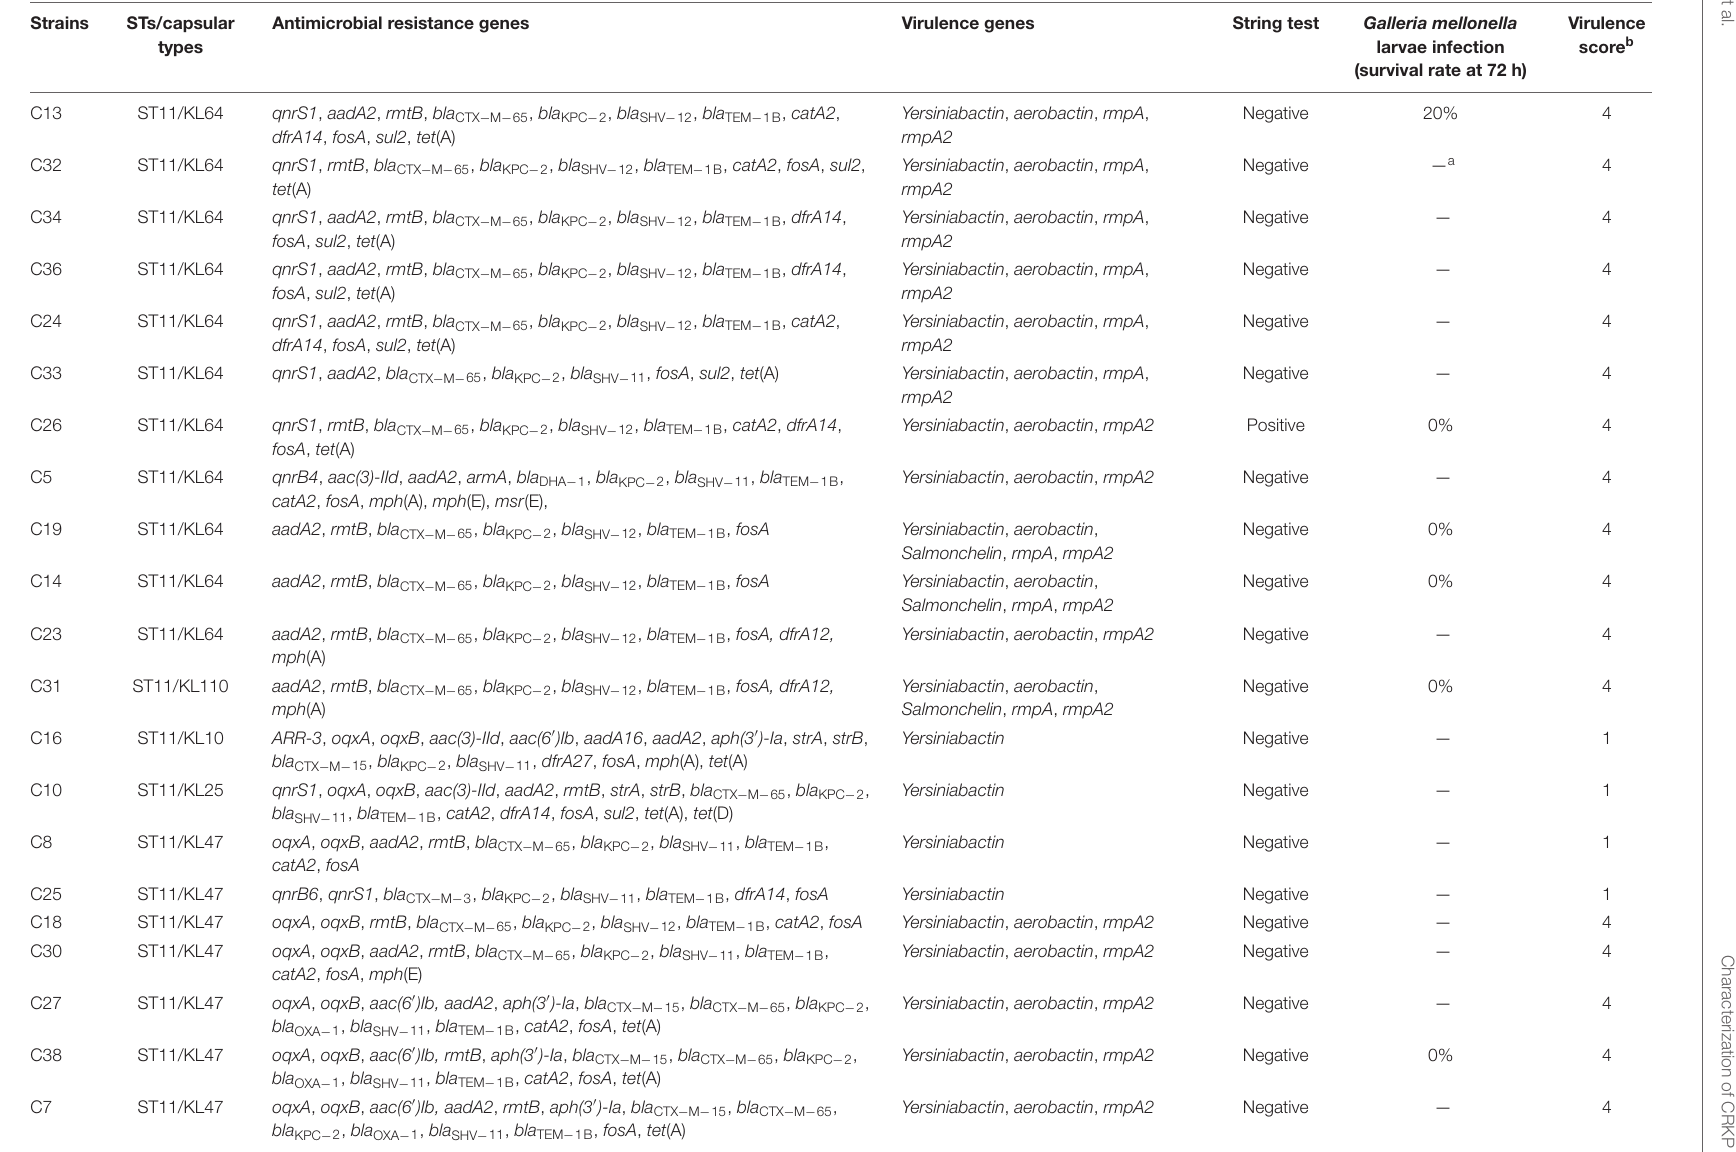
TABLE 1 | Summary of all carbapenem-resistant Klebsiella pneumoniae strains revealed by WGS data and virulence assay in this study.